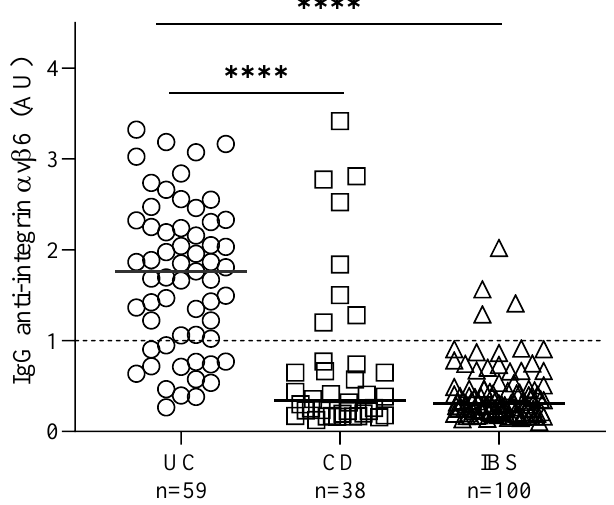
Figure 1. Serum IgG anti-integrin α v β 6 autoantibodies in patients with ulcerative colitis (UC), Crohn’s disease (CD), and irritable bowel syndrome (IBS). The dashed line indicates the assay cut-off level based on the 95th percentile for the HC group. Median and significant differences between the groups are indicated (**** p < 0.0001).